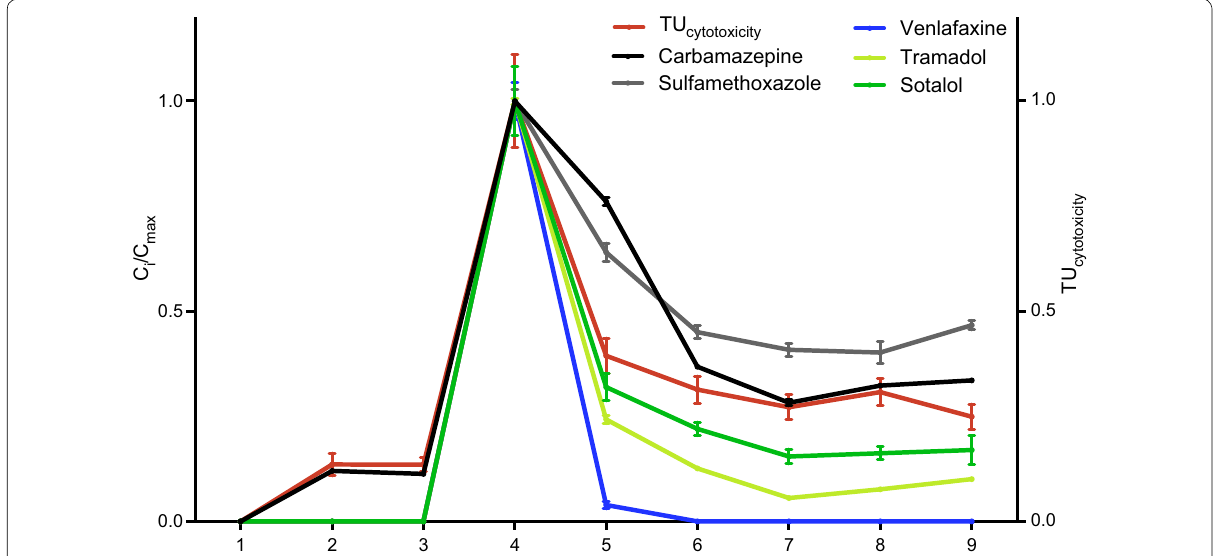
Fig. 3 Concentrations of carbamazepine (CAR), sulfamethoxazole (SUL), tramadol (TRA), sotalol (SOL) and venlafaxine (VEN) and the cytotoxicity expressed as TU cytotoxicity relative to the maximum concentration and maximum cytotoxicity, respectively, along the Ammer